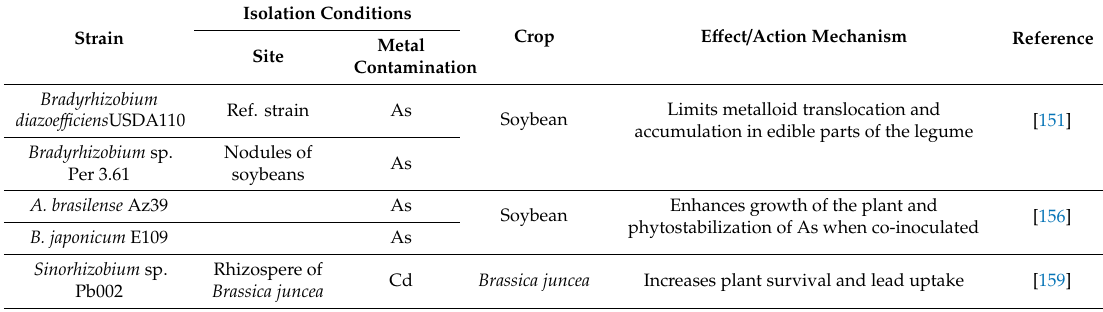
Table 1. Studies of plant growth improvement mediated by rhizobium-inoculants on harsh